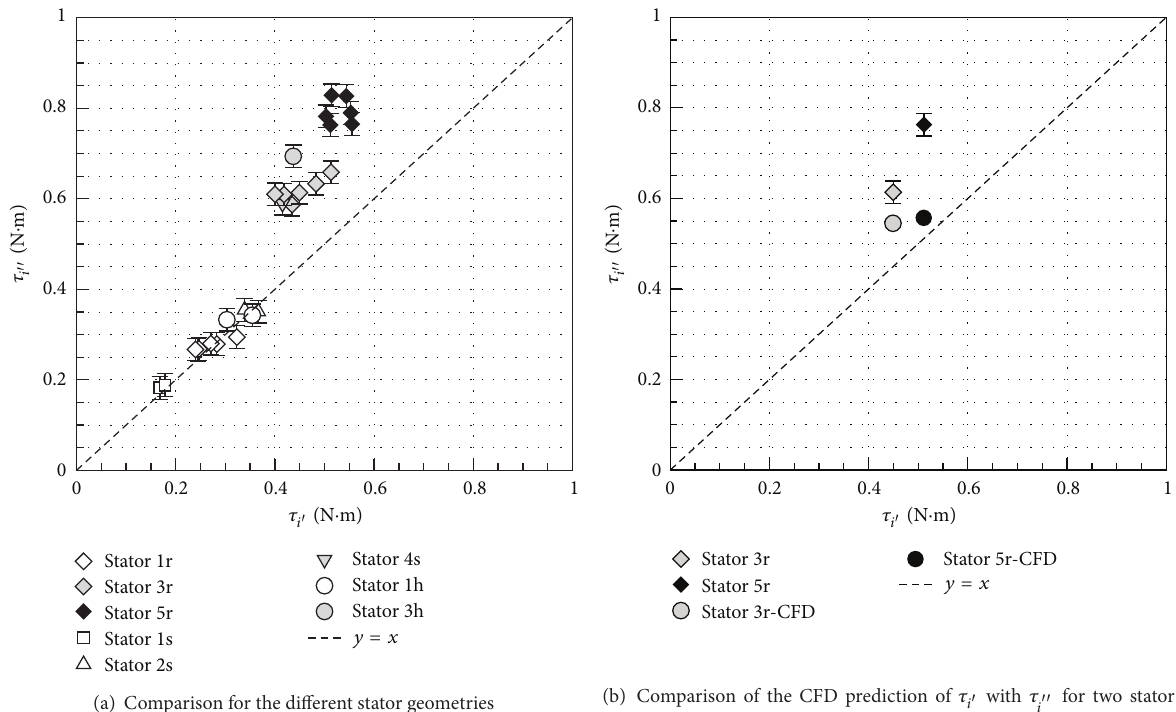
Figure 8: Comparison of the initial estimation of the torque at the point 𝑖 󸀠 given by (9) with the back-deduction of the torque through the response time ( 𝜏 𝑖 󸀠󸀠